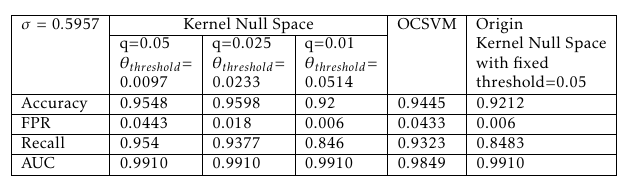
Table 3. Performance Comparison